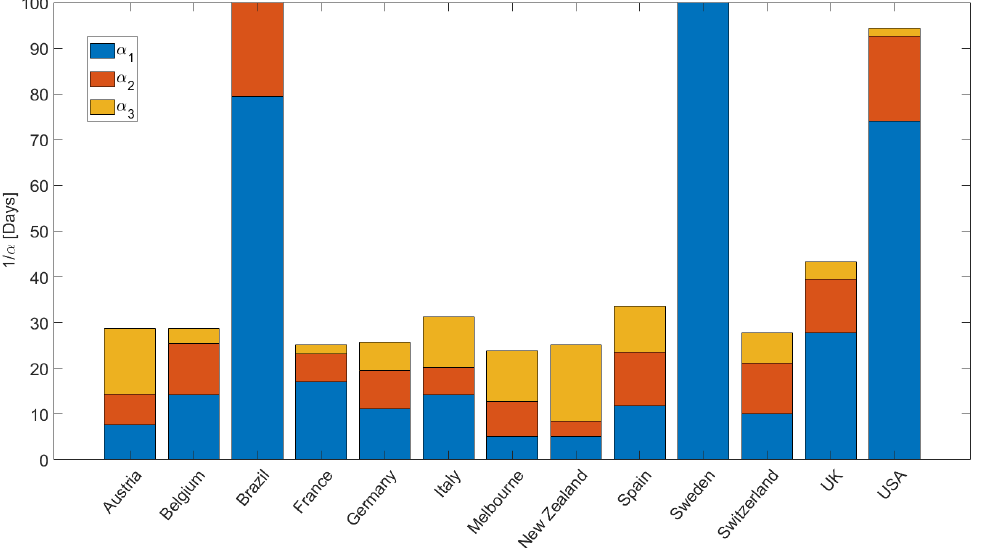
Figure 5. Summary of α values used in the simulations, showing a wide range of recovery times for different countries. α 1 (blue) represents the recovery time of the first wave, α 2 (orange) represents the second wave, and α 3 (yellow) represents the recovery of the on-going third